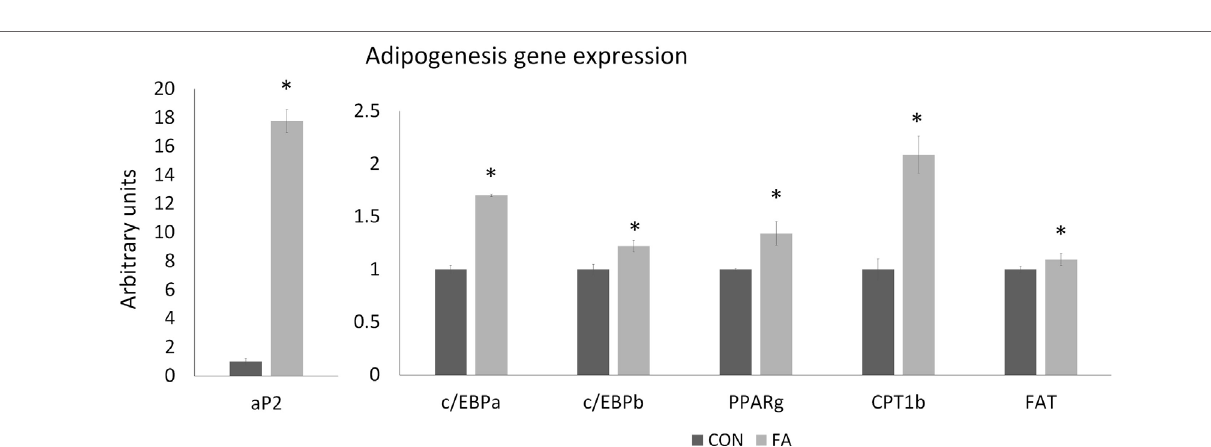
FigUre 3 | The relative gene expression related to adipogenesis of C2C12 cells in control (CON) and EPA/DHA (FA) medium. Data show the change of their mRNA expression in FA group compared with CON group. The relative expressions were calculated in arbitrary units. * P < 0.05; n = 3.